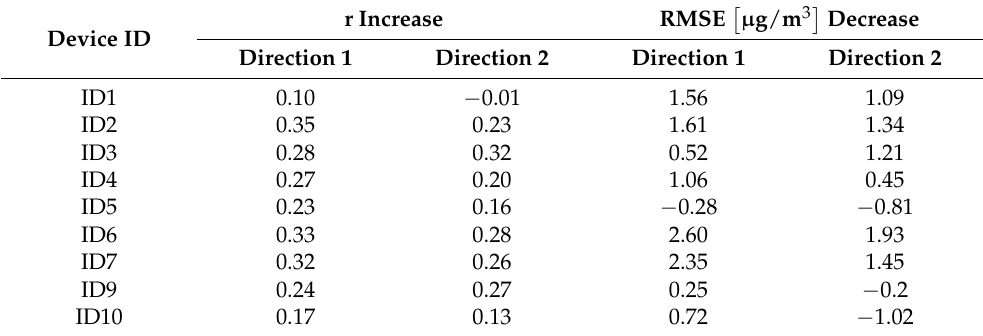
Table 4. Results of the NO 2 calibration propagation in May, improvements in comparison to the parameters before calibration.